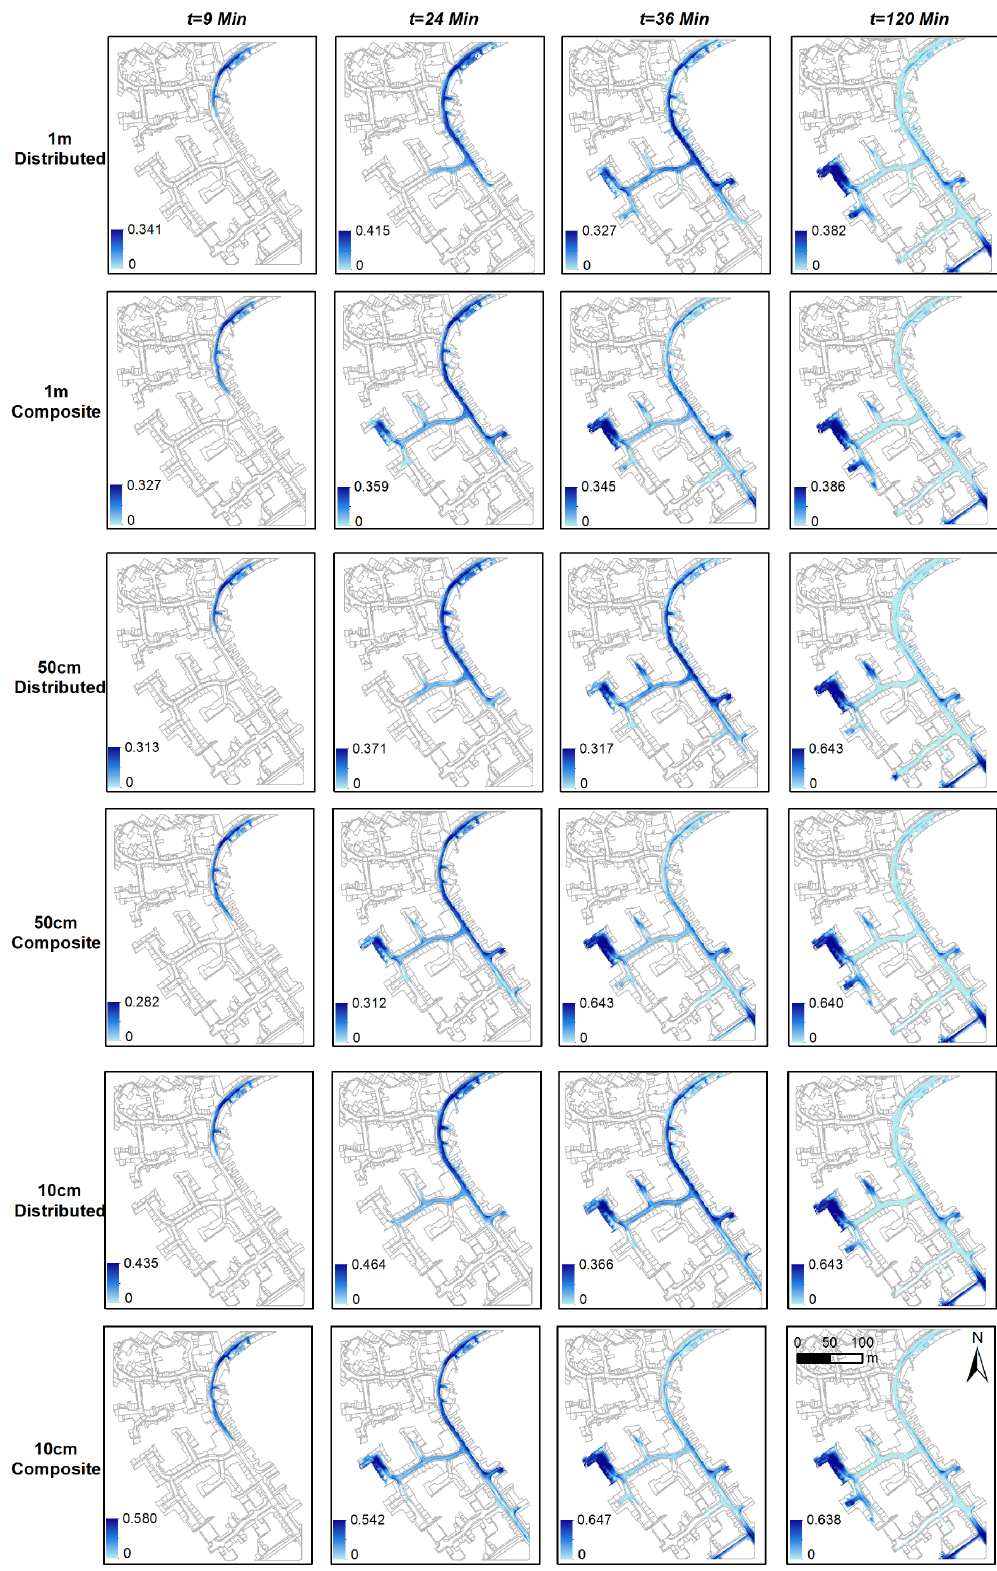
Fig. 6. Progression of surface flooding predicted by different resolution and roughness conditions using the new inertial formulation.